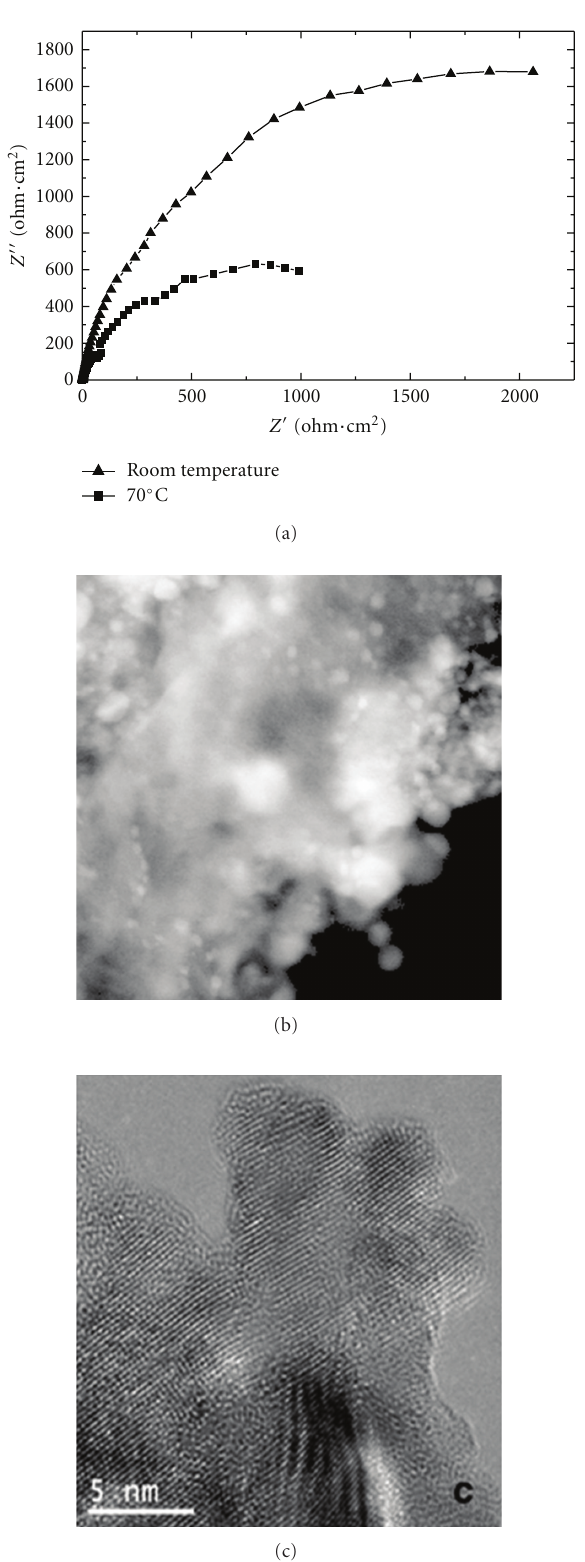
Figure 6: (a) EIS Nyquist plots in pH 11 solution at room tem- perature and 70 ◦ C, (b) FeAl particle TEM micrograph obtained by Z contrast after corrosion tests, and (c) FeAl TEM high-resolution image after corrosion tests.